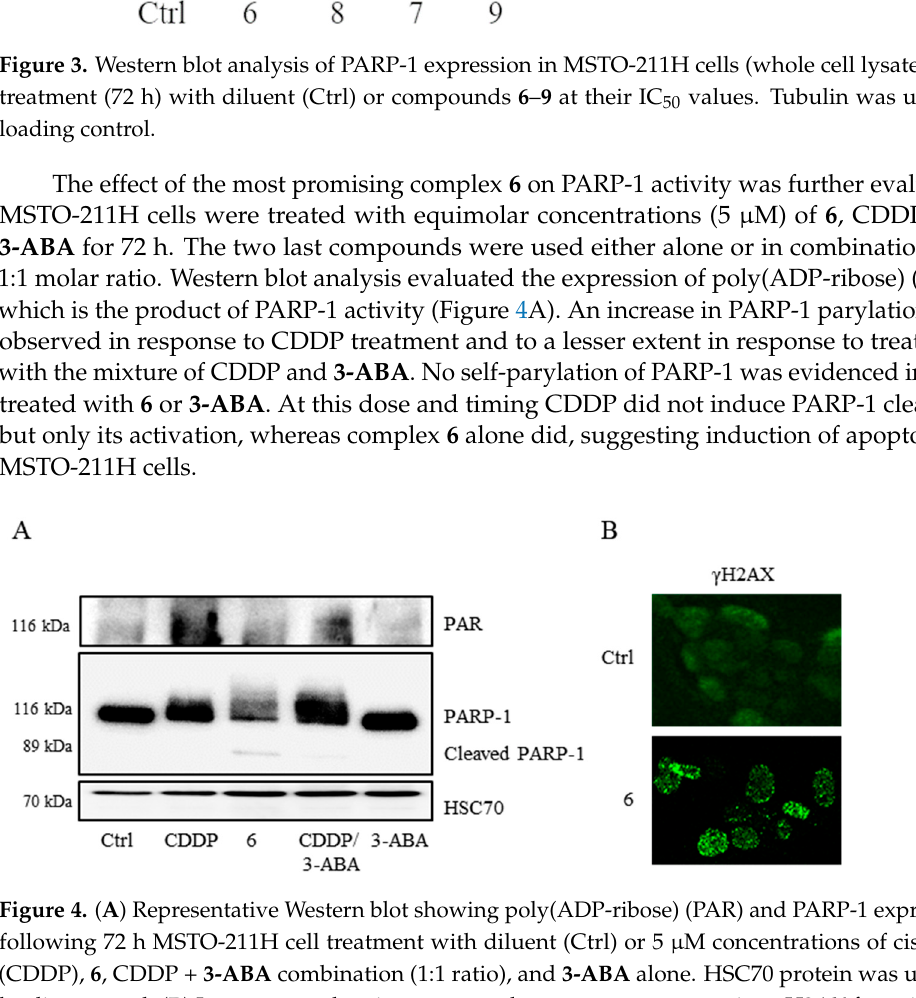
Figure 3. Western blot analysis of PARP-1 expression in MSTO-211H cells (whole cell lysate) after treatment (72 h) with diluent (Ctrl) or compounds 6 – 9 at their IC 50 values. Tubulin was used as loading control.